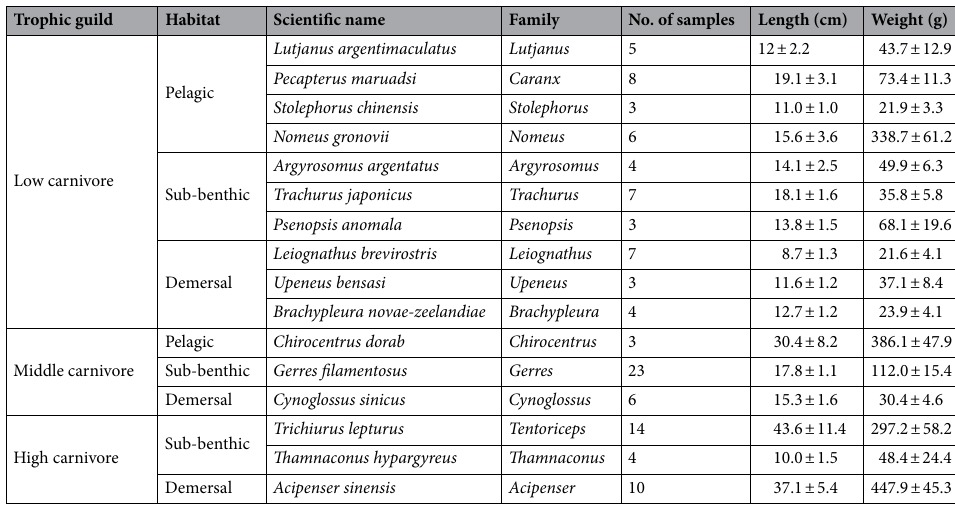
Table 2. The ecological characteristics and recorded morphometric measures of sixteen fish species collected from Xincun Lagoon, South China